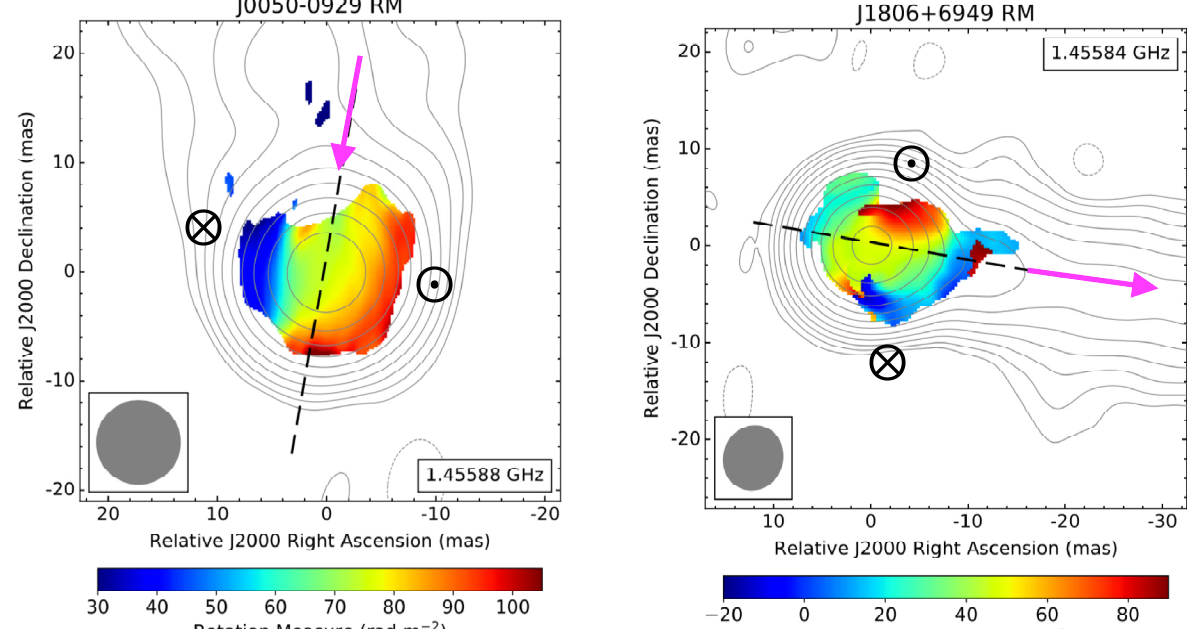
Figure 1. Two examples of transverse Faraday rotation (RM) gradients detected across parsec-scale core–jet structures. The circled dots and crosses indicate the sides of the jet where the toroidal B -field component is oriented toward and away from the observer, respectively. The pink arrows show the inferred direction of the current along the local jet axis, shown by the dashed line. The sizes of the Gaussian restoring beams are shown by the ellipses in the bottom left-hand corners of the images. The RM maps used to make this figure were made and provided by Frederick